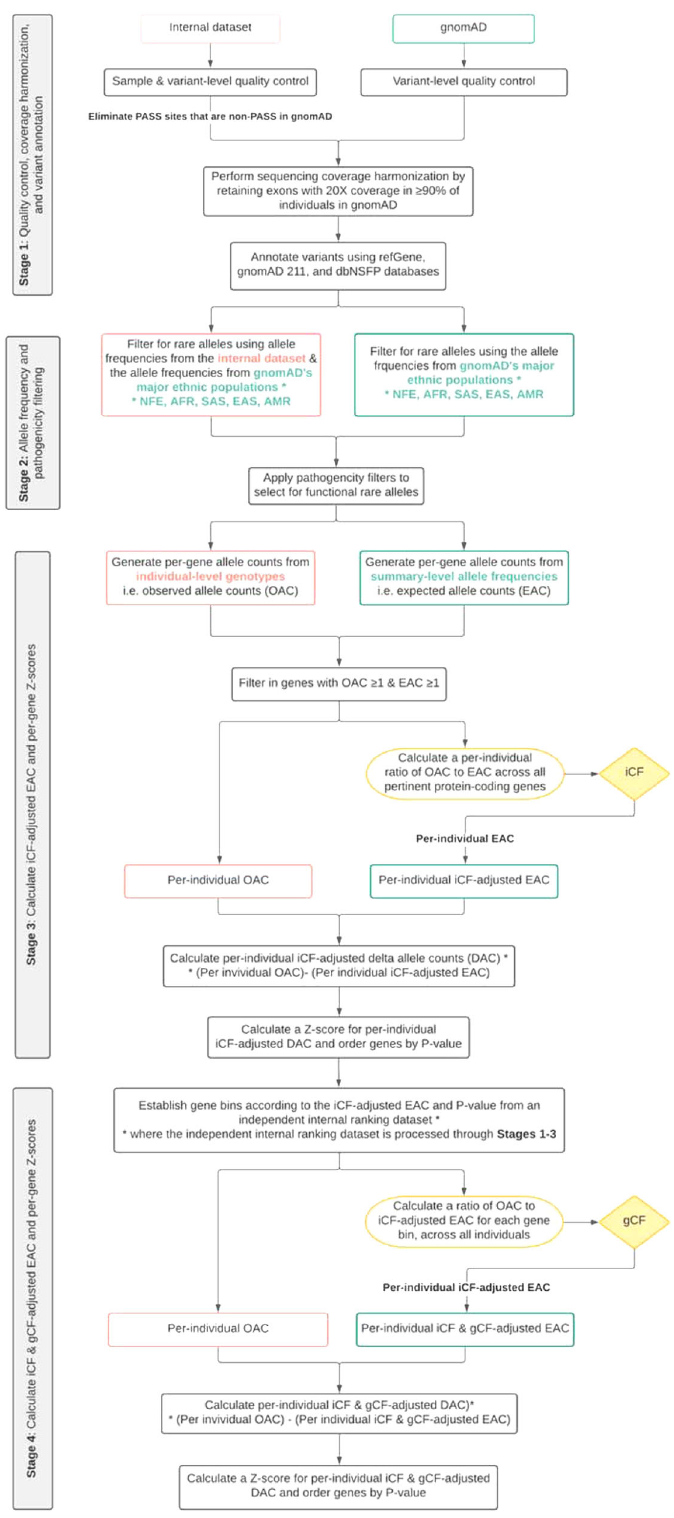
Fig. 1 Schematic describing the RV-EXCALIBER pipeline. RV-EXCALIBER can be divided into 4 distinct stages where stage 1 and 2 are preprocessing steps and stages 3 and 4 encapsulate the three major RV-EXCALBER adjustments: the implementation of the correction factors (iCF and gCF) and Z -score calculations for per-gene delta counts. MAF indicates minor allele frequency, iCF indicates individual correction factor, gCF indicates gene correction factor, NFE indicates non-Finnish European, AFR indicates Africa, SAS indicates South Asian, EAS indicates East Asian, and AMR indicates